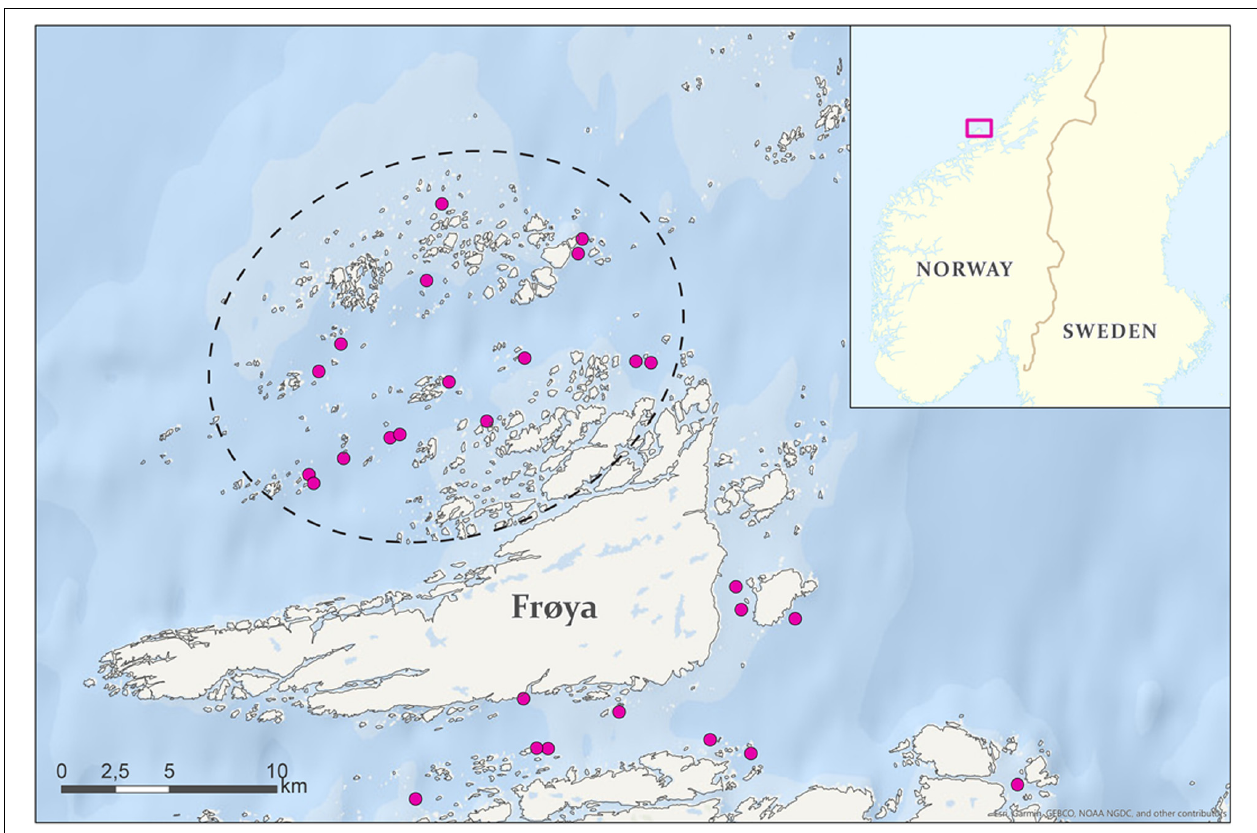
FIGURE 1 | Map over study site (inside black dash circle). Circles indicate salmon farms. Map created by Tale Skrove.© Kartverket© Europa wms.